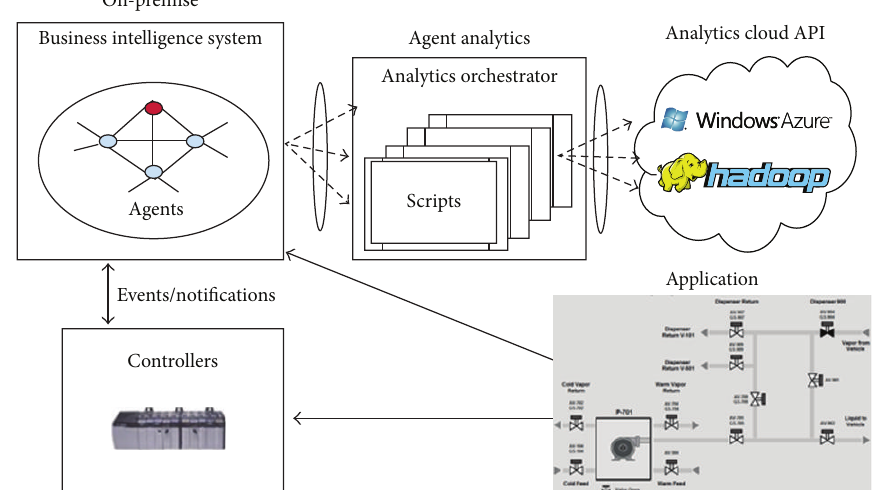
Figure 2: Data ingestion